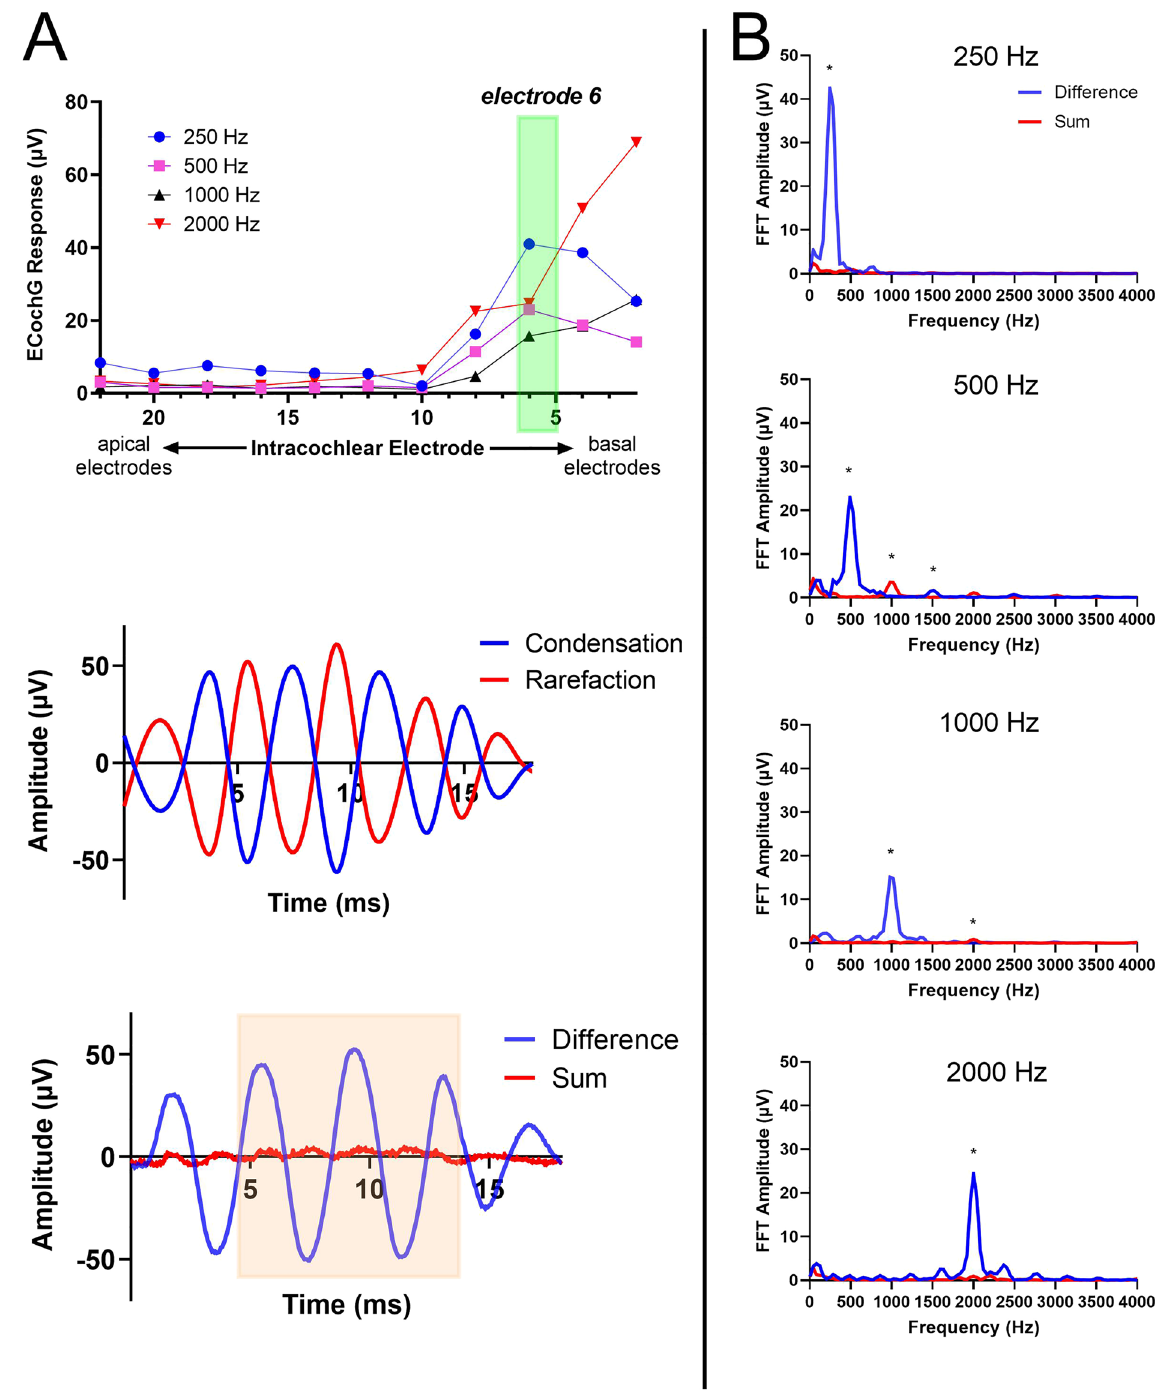
Figure 6. Sample ECochG recording and calculation of the electrocochleography total response (ECochG-TR). The electrode sweep is first collected across 4 frequencies using tone bursts—250, 500, 1000, and 2000 Hz ( A , top panel). A representative response to 250 Hz tone burst is shown in ( A , middle and lower panels). The stimulus alternated in phase, and both the condensation and rarefaction phases are shown ( A , middle panel). The difference and sum waveforms are calculated from the condensation and rarefaction waveforms ( A , lower panel). A window for the ongoing steady state response is selected from the difference and sum waveforms as shown in orange (4 to 14 ms) to compute the fast Fourier transformations ( A , lower panel). ( B ) Magnitude spectra for each stimulus frequency with significant responses (250 to 2000 Hz). For each stimulus frequency, the magnitudes of the first three harmonic peaks were compared to the noise floor. Those that were significantly above the noise floor (asterisks, see text for test of significance) were added to produce the